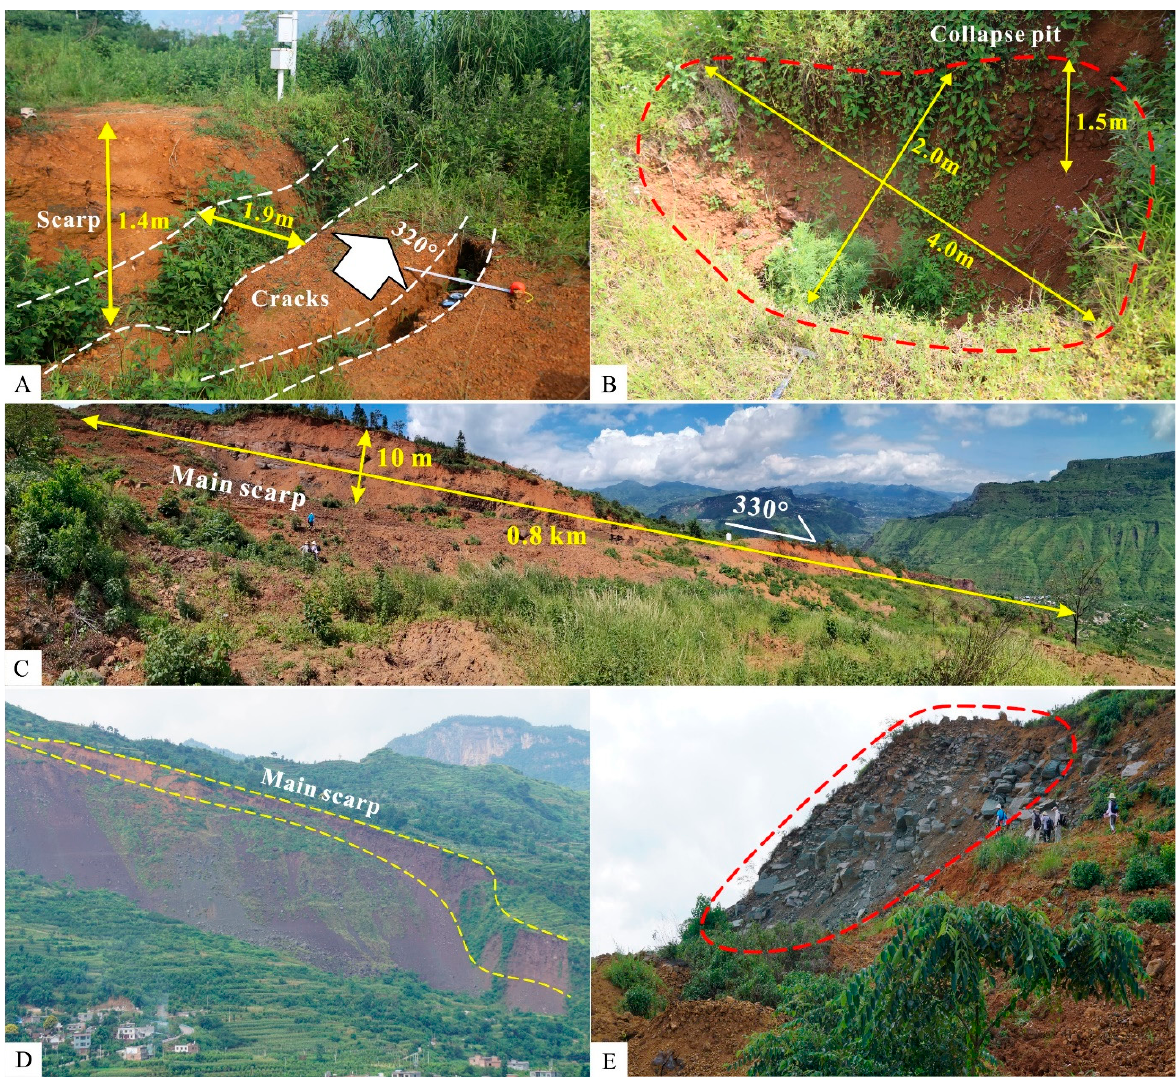
Figure 12. Deformation characteristics of zone I: ( A ) subsidence scarp and tensile cracks; ( B ) collapse pit; ( C ) scarp at the rear edge; ( D ) front view of NW side; and ( E ) bulging of landslide surface. The specific locations of features A–E are shown in Figure 8.